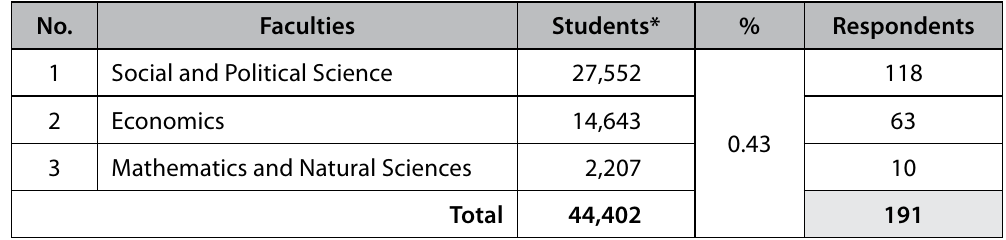
Table 1 Total number of students and required